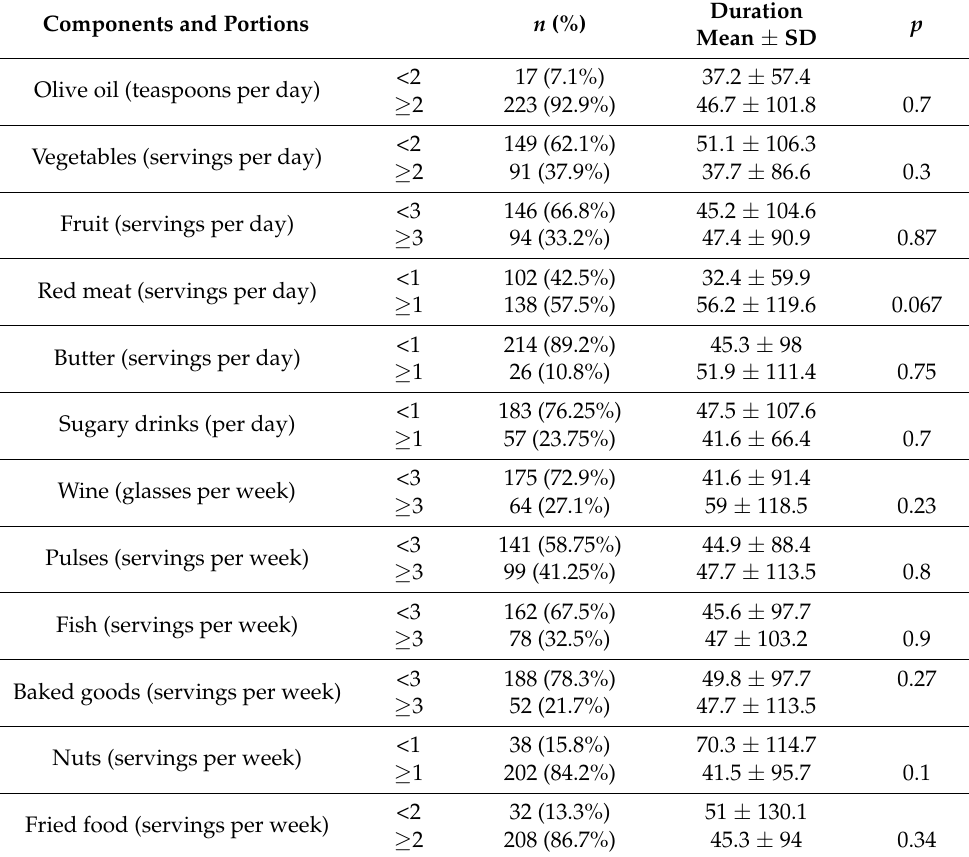
Table 3. Components of AMD and duration of common illness/workplace